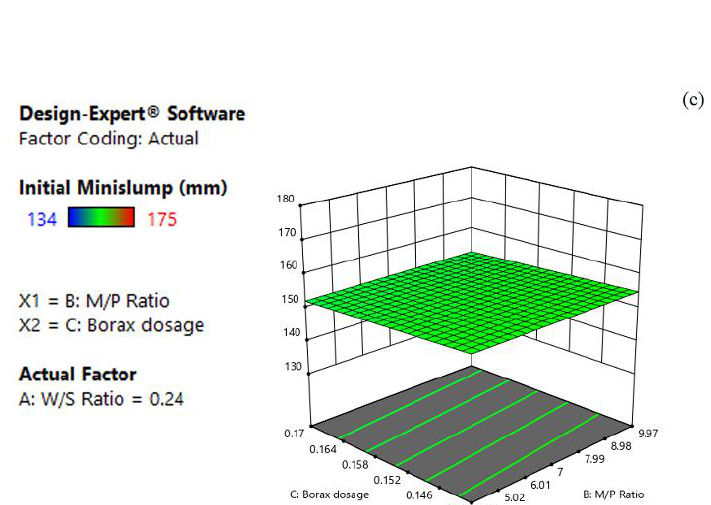
Figure 3. Three-dimension response surface plots of initial mini slump (Y 1 ) in relation to: ( a ) W/S ratio (X 1 ) and M/P ratio (X 2 ); ( b ) W/S ratio (X 1 ) and borax dosage (X 3 ); ( c ) M/P ratio (X 2 ) and borax dosage (X 3 ).